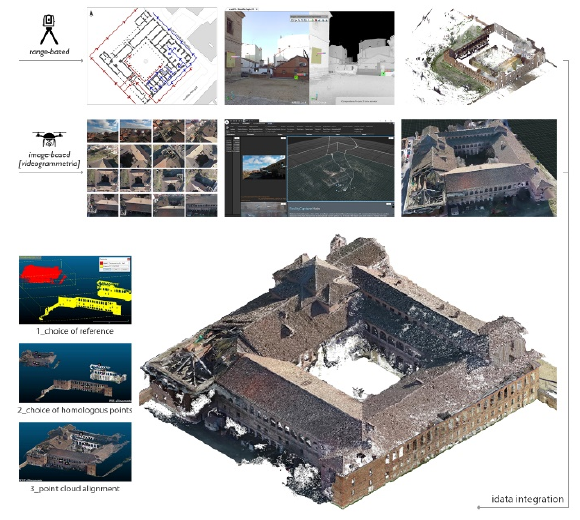
Figure 4: Point cloud of the Simón Ruiz Hospital obtained from the integration of reality-based surveys.